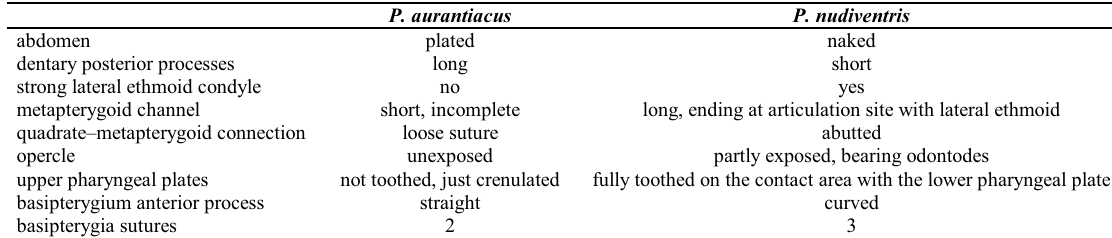
Table 2 . Summary of differences between Parancistrus aurantiacus and P.